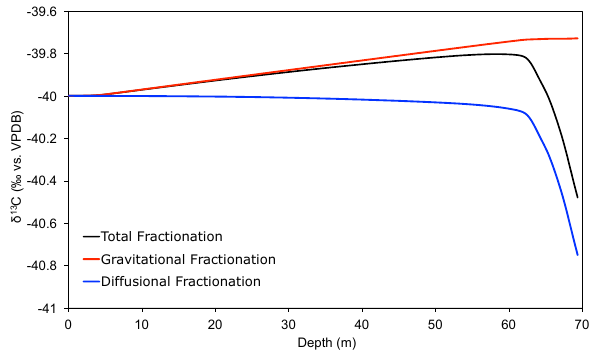
Fig. 8. CFC-12 δ 13 C Modeled fractionation effects from gravitation (red) and diffusion (blue) and the sum thereof (black) based on a constant atmospheric δ 13 C ( − 40‰) with time scenario input to the forward